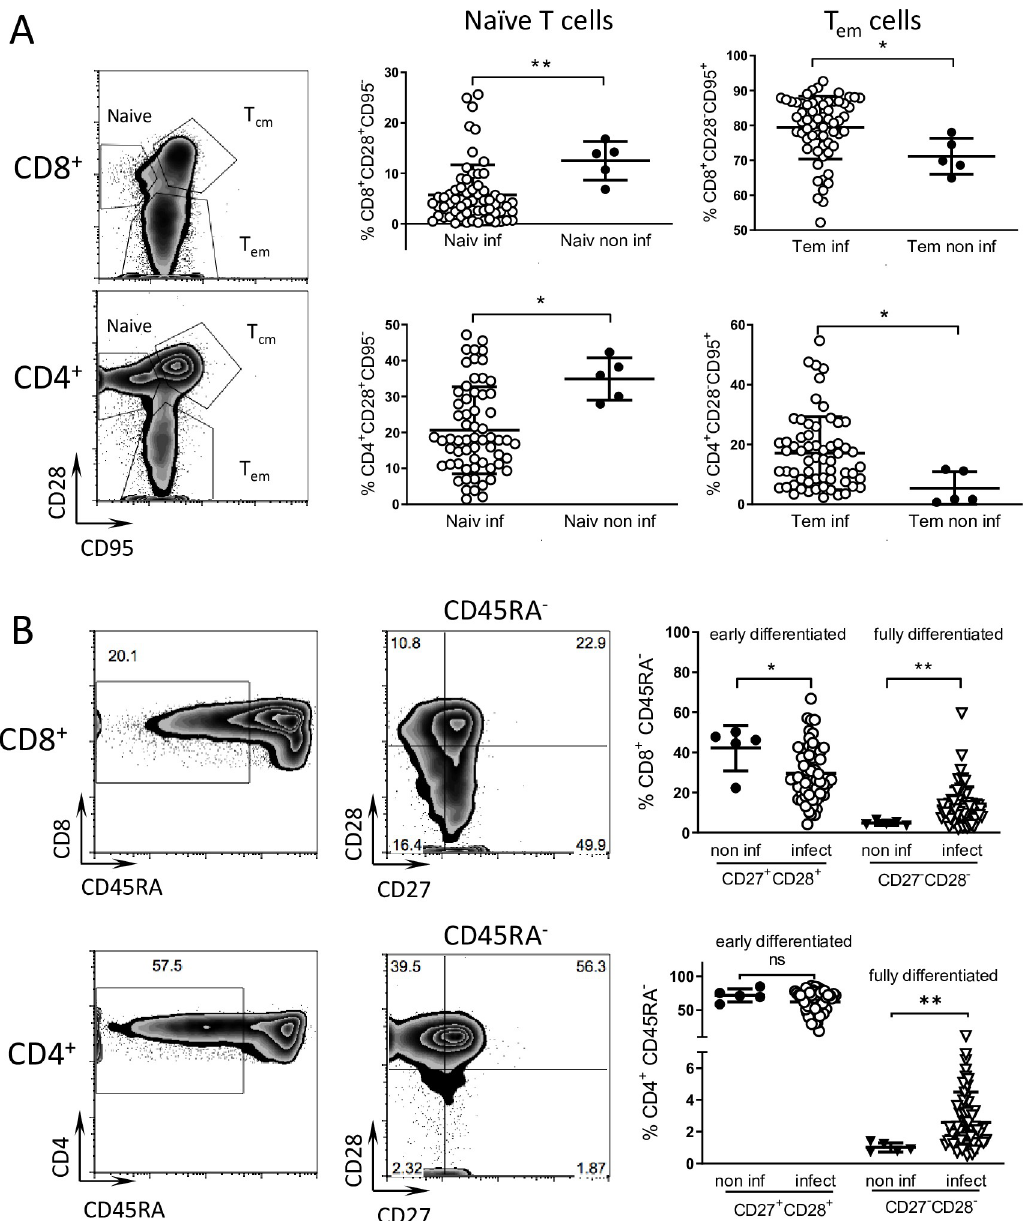
Fig 5. Phenotype of T cell subpopulation reflects the infected status of seropositive macaques. Peripheral blood samples were stained for cell surface markers and analyzed by flow cytometry. (A) CD8 + and CD4 + T cell populations were subdivided into naive, T central memory (T cm ) and T effector memory (T em ) subpopulations based on the expression of CD28 and CD95. Naiv inf: naive T cells in infected macaques, Naiv non inf: naive T cells in non-infected macaques, Tem inf: T effector memory cells in infected macaques, Tem non inf: T effector memory cells in non-infected macaques. (B) Early differentiated T cells (CD45RA - CD28 + CD27 + ) and fully differentiated T cells (CD45RA - CD28 - CD27 - ) subpopulations were identified inside CD8 + and CD4 + T cell populations for non-infected (non inf; n = 5) and infected (infect; n = 62) macaques. Representative dot plots of infected macaques are shown. Numbers in the dot plots indicate the percentage of events in the gate or quadrant out of the displayed population. � = p < 0.05, �� = p < 0.01 by Mann Whitney